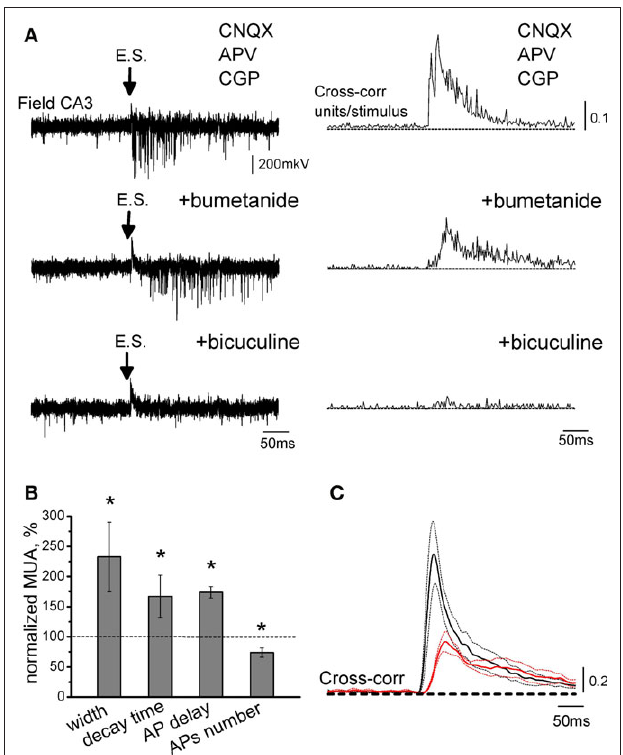
Figure 4 | effect of partial blockade of NKCC1 co-transporter on action potential delays at gABAergic synapses. (A) Extracellular recordings of MUA evoked by electrical stimulation (E.S.) in the presence of the glutamate and GABA(B) receptor antagonists from the CA3 layer of P5 rat hippocampus (top: control, middle: 0.3 μM bumetanide and bottom: 20 μM bicuculline). On the right are shown corresponding cross-correlograms of the AP times versus stimulus. (B) Summary plot of the effects of low-bumetanide on synaptic GABA-evoked MUA. (C) Average cross-correlograms in control conditions (black) and in the presence of 0.3–0.6 μM bumetanide (red) ( n = 4 slices; P2–5 rats). Dashed lines show SEM. Note that partial blockade of NKCC1 co-transporter increases AP delays and their jitter, and decreases APs